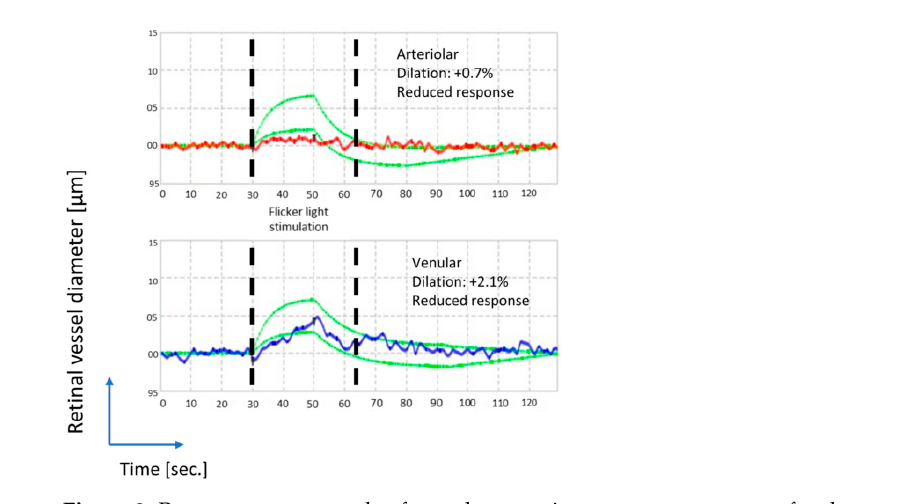
Figure 1. A vessel map of the retinal oximetry image (RO) shows color-coded oxygen saturation (SO 2 ) values of retinal vessels within the peripapillary annulus of a glaucoma patient (right eye). We evaluated the average SO 2 parameters (A-SO 2 , V-SO 2 and A-V SO 2 ; %).